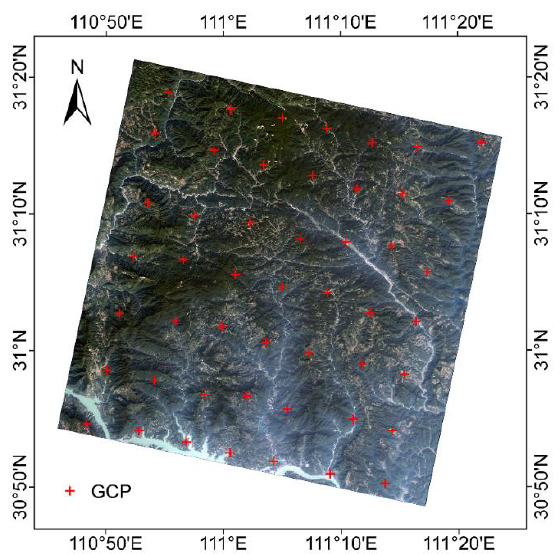
Figure 4. The GCPs and ZY-3 multi-spectral image. We set 49 GCPs manually in the vegetation-free areas and derived the elevation of the GCPs from the SRTMGL1.